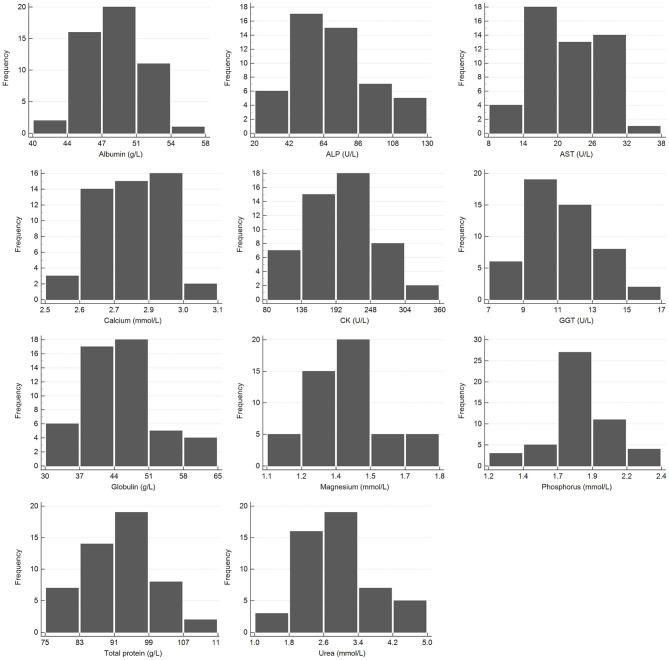
Histogram showing the distribution of results for clinical chemistry measurands from the African elephant (Loxodonta africana) for the Abaxis Vetscan VS2. The x-axis represents the measurand result; the y-axis represents the frequency of these occurring.